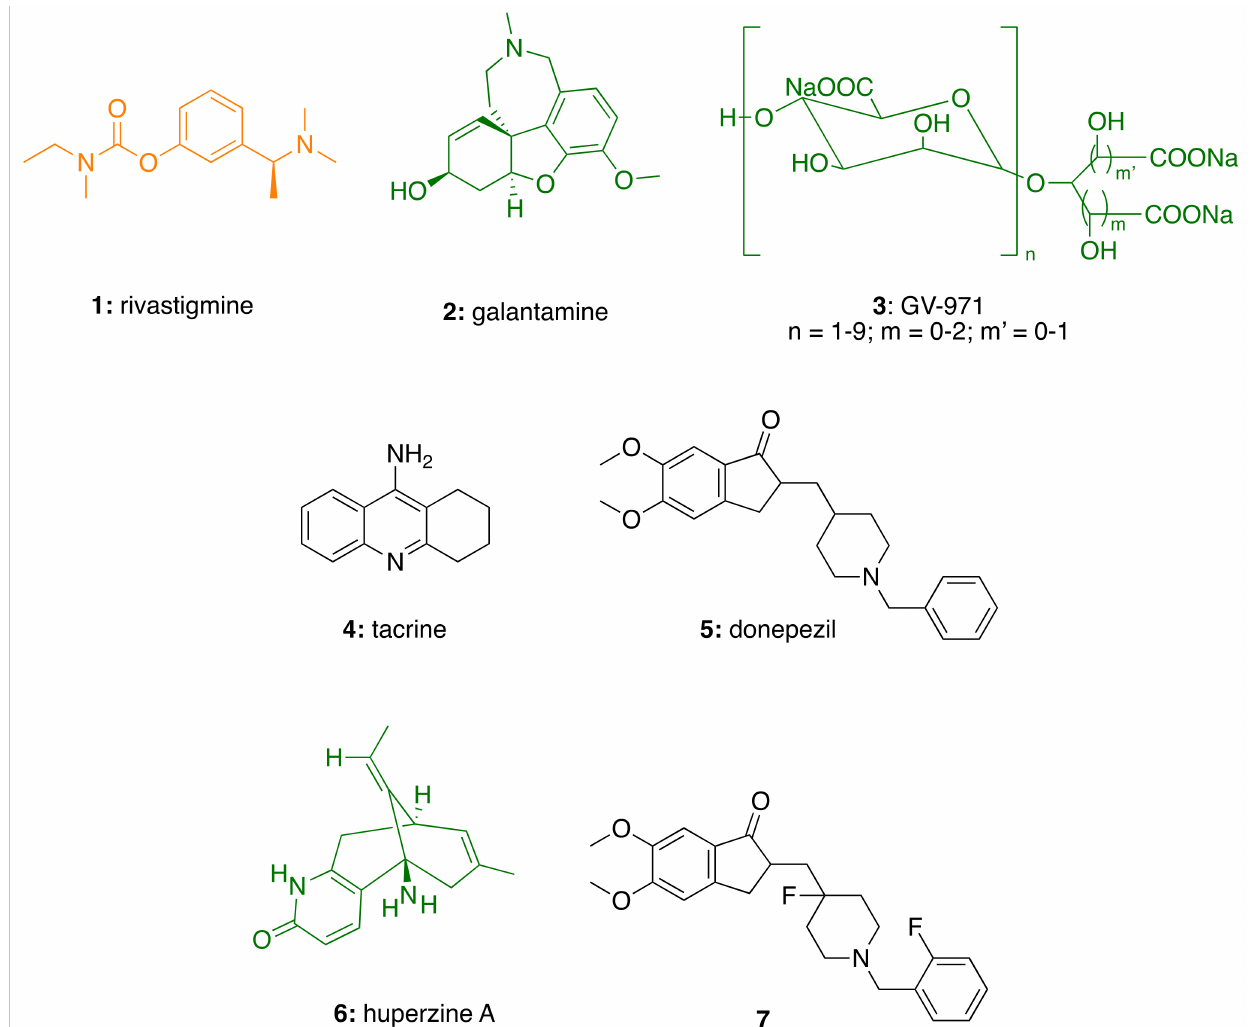
Figure 1. Structures of natural product (in green) and natural product-derived (in orange) and synthetic (in black) anti-AD marketed and investigational